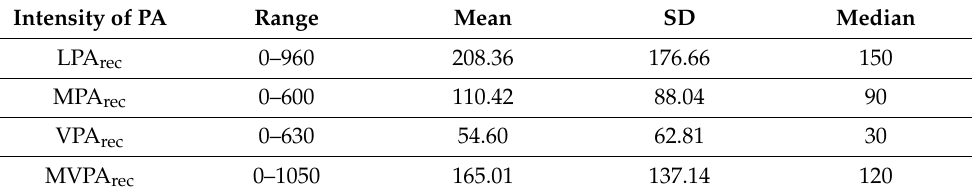
Table 1. Mean, Median and SD of suggested minutes of PA per intensity.